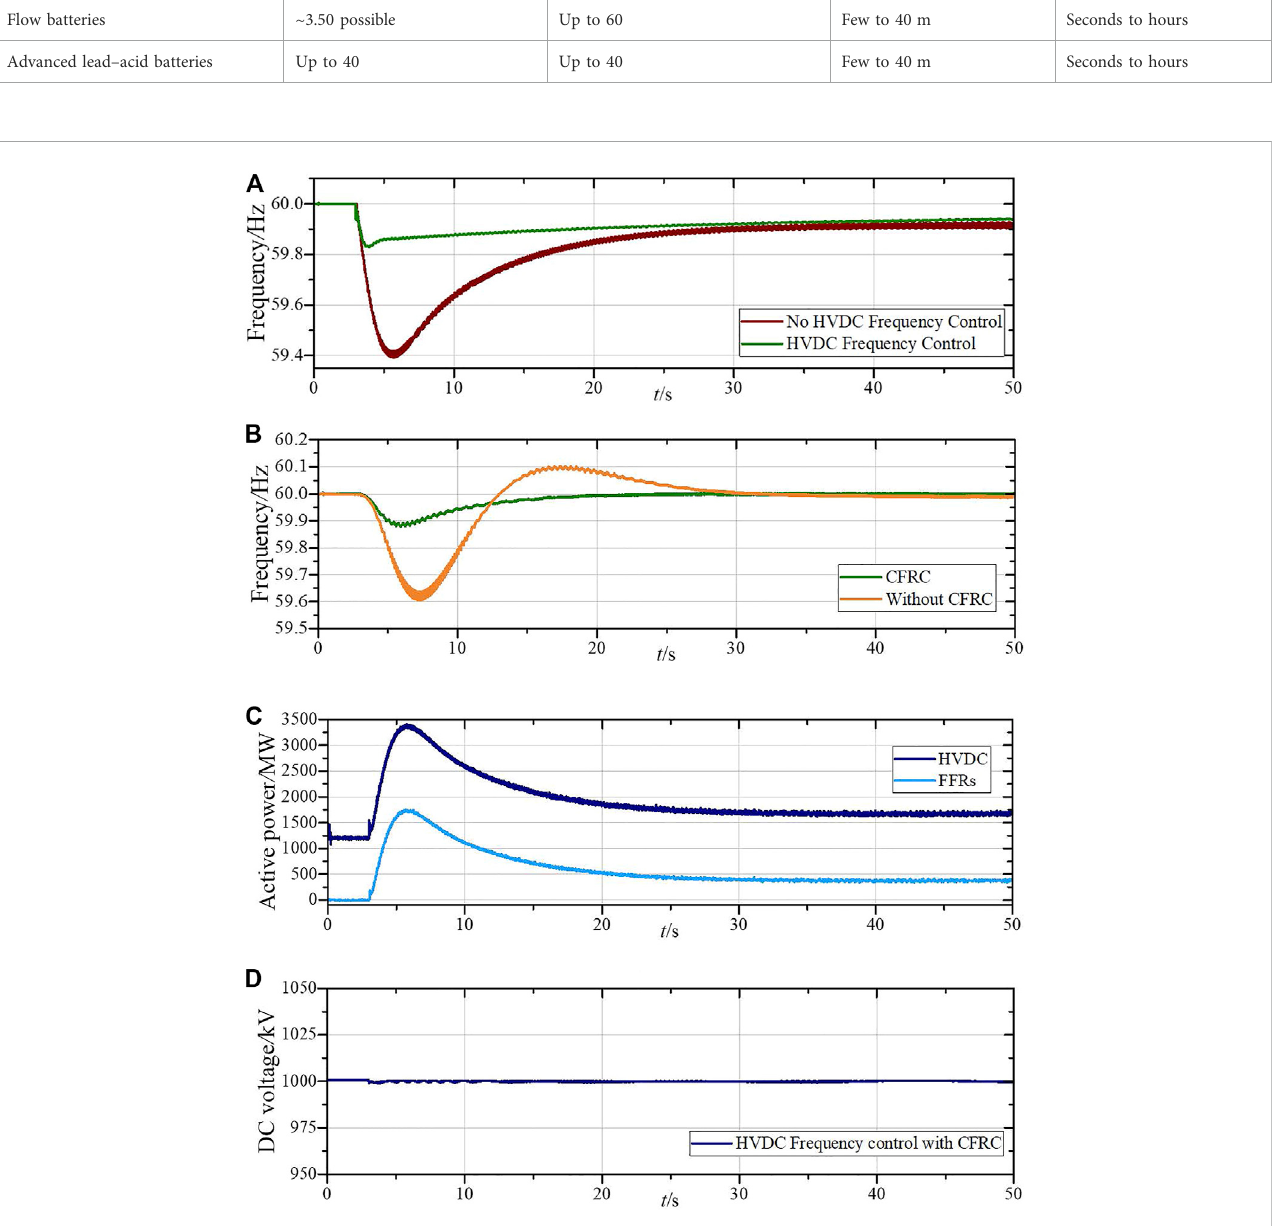
FIGURE 9 Simulation results of the VSC-HVDC system in frequency control. (A) Frequency of the EI with HVDC frequency control and without HVDC frequency control. (B) Frequency of the WECC with and without CFRC. (C) Power fl ow on the VSC-HVDC system and the output of FFRs. (D) DC voltage of the VSC- HVDC system during the HVDC frequency control with the